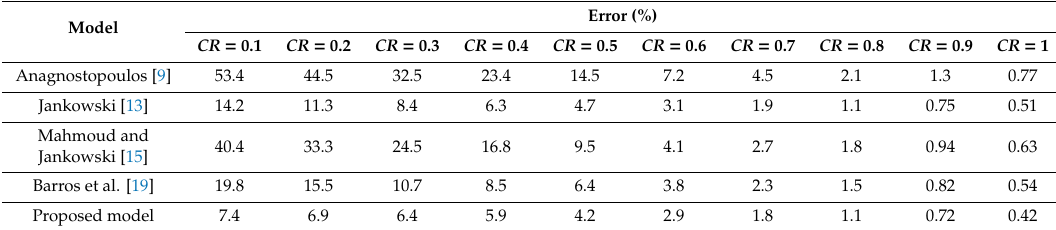
Table 1. Errors between selected and calculated CR values for di ff erent impact force models. Model